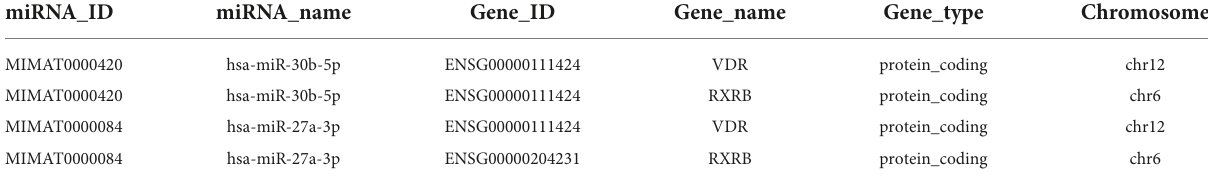
TABLE 3 ENCORI miRNA-mRNA Interactions.